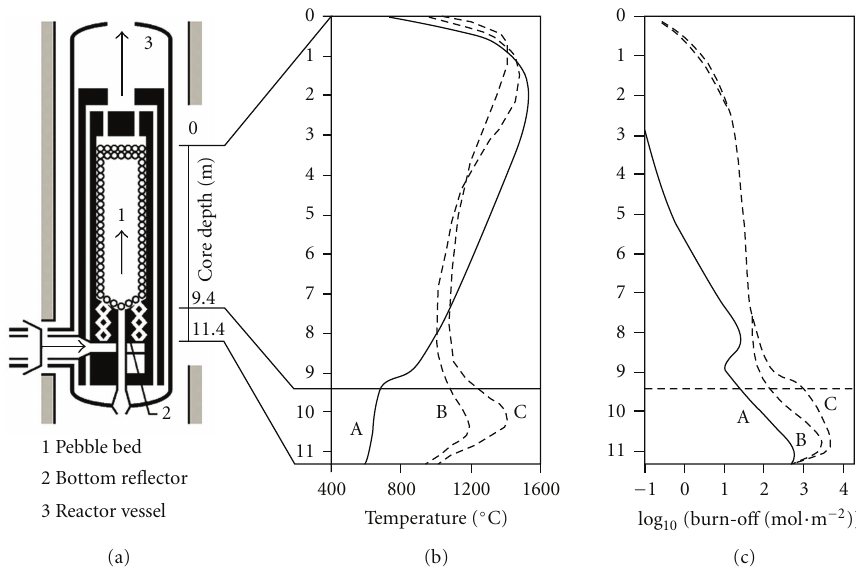
Figure 13: Schema of the HTR-Modul200 with flow pattern in assumed air ingress (a). Calculation results on core temperatures (b) and graphite burn-o ff in the central core axis (c) 20 h after air ingress start (air flow: A = 0.02, B = 0.3, C = 0.6